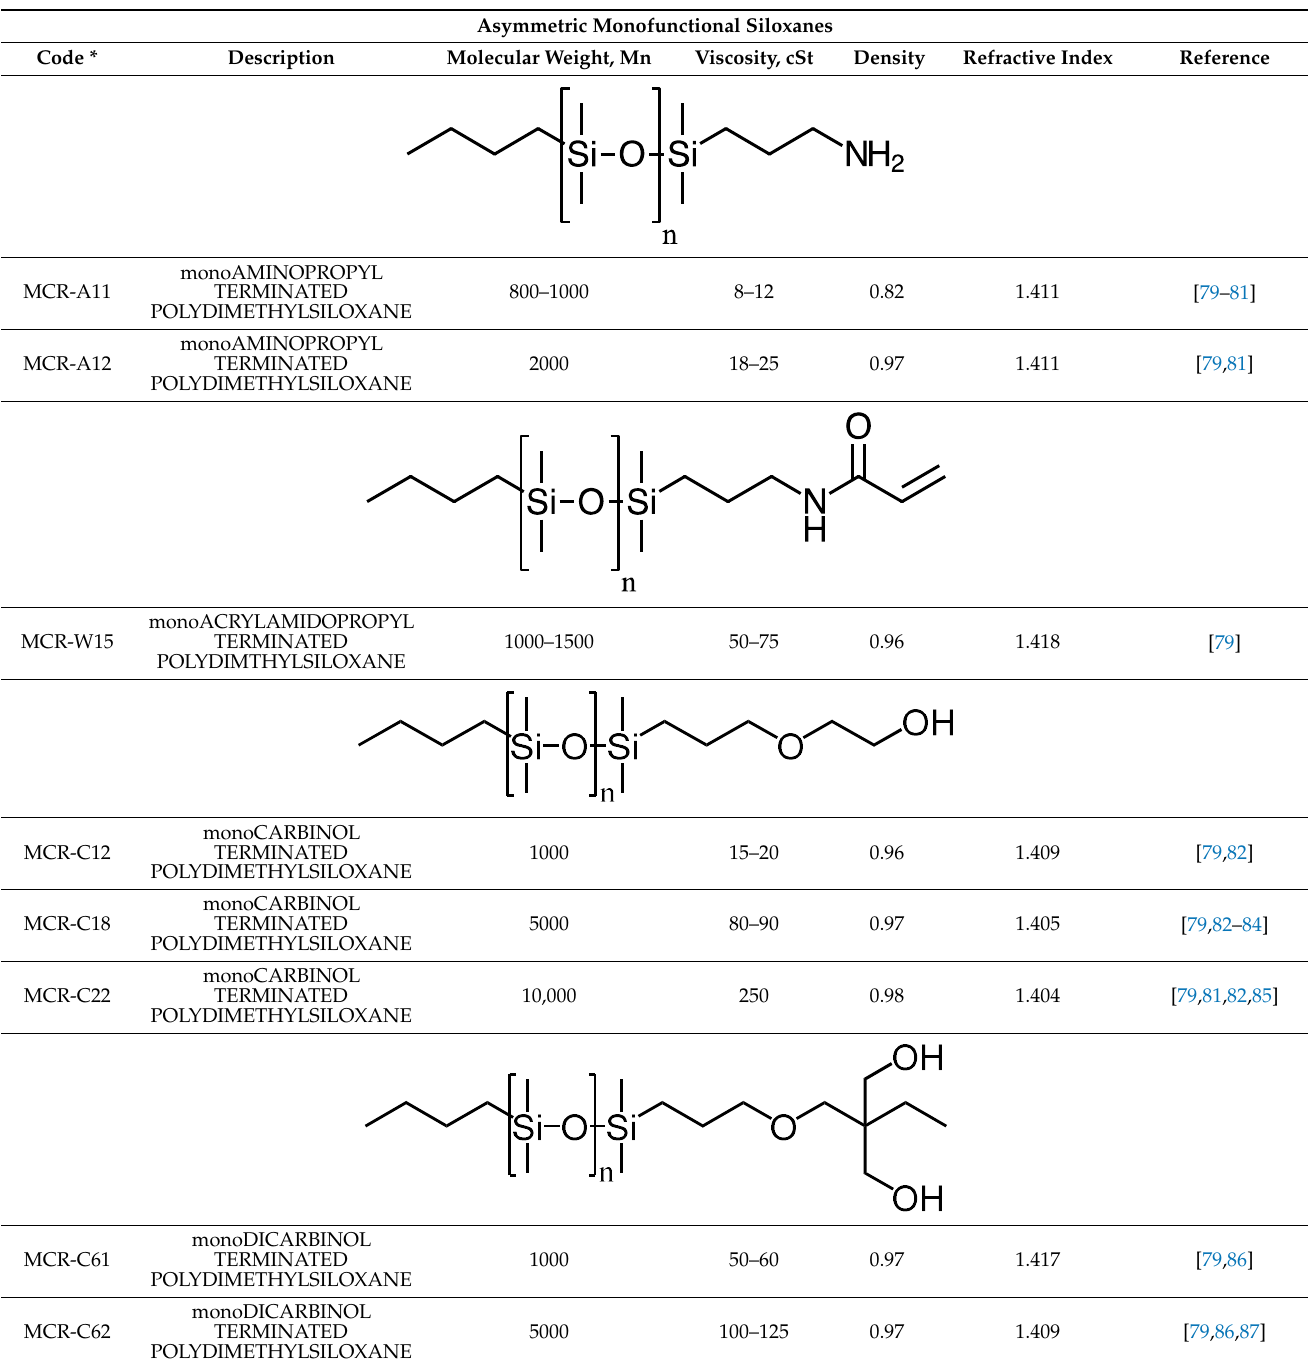
Table 3. Commonly Reported Macromers.